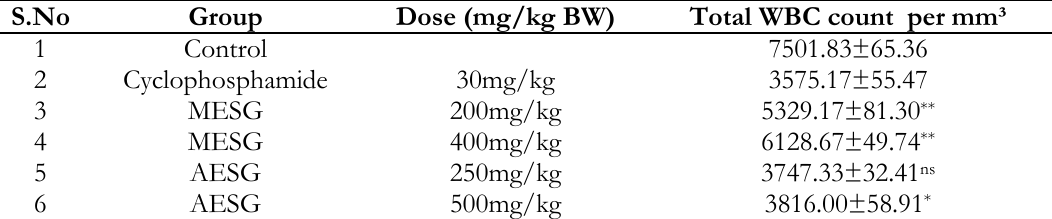
Table III. Effect of Sesbania grandiflora flowers on cyclophosphamide-induced myelosuppression.